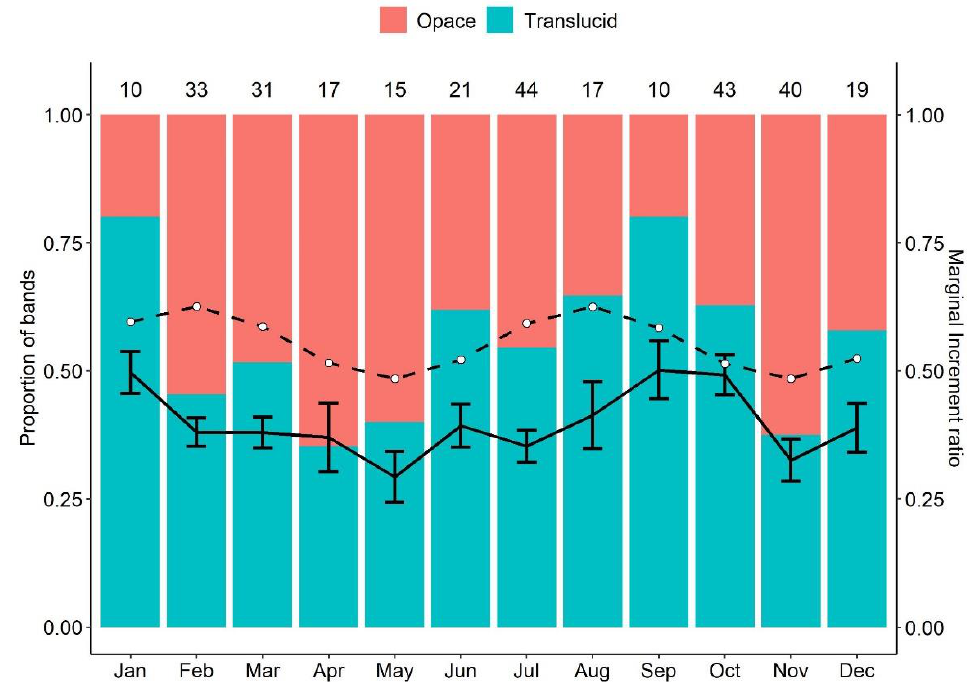
Figure 3. The opaque and translucent proportion of vertebral band (dashed line) and marginal increment ratio (continuous line with standard deviation) of Urotrygon microphthalmum from northeastern Brazil.